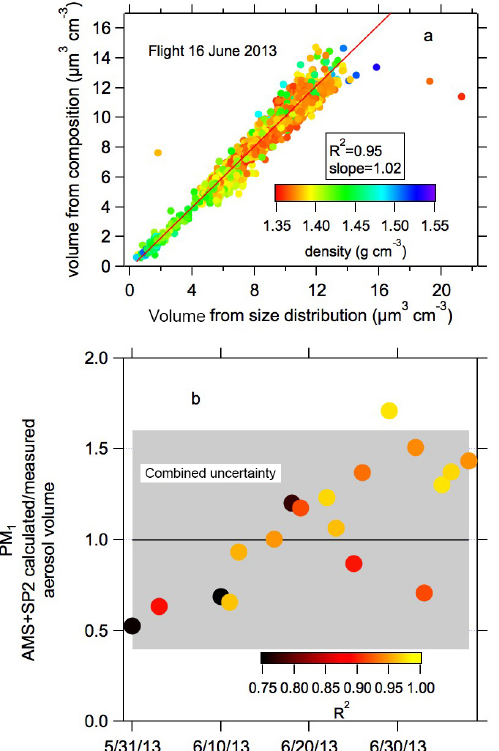
Figure 8. The aerosol volume derived from the chemical compo- sition data (AMS and SP2) was compared to the volume from the size distribution data (NMASS and UHSAS). (a) The correlation for the flight on 16 June 2013 color-coded by the density. (b) The slopes for all the flights color-coded by the respective correlation coefficient determined as shown in (a)